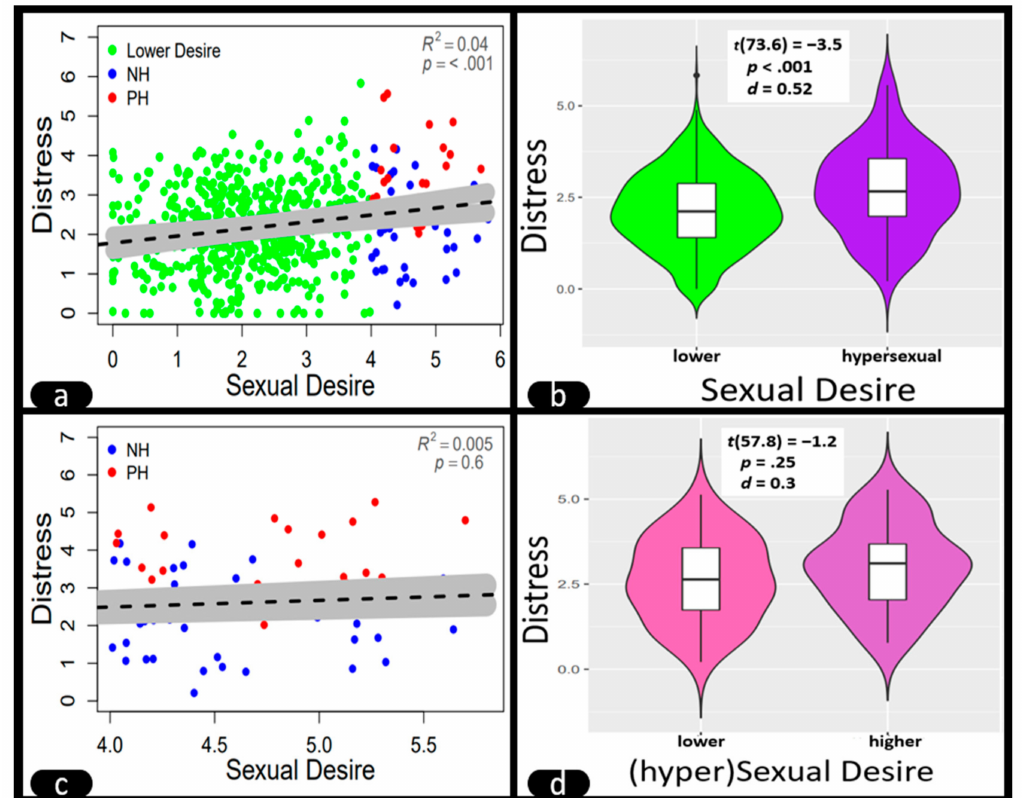
Figure 2. Comparing relevant subpopulations. ( a ) Scatterplot of sexual desire and distress in a general population sample. Part of this sample can be considered as PH (=red) or NH (=blue). Sexual desire is positively associated with distress. ( b ) Violin and boxplot comparing lower sexual desire and the hypersexual desire subsamples on levels of distress. The hypersexual sample (PH and NH) experiences significantly more distress than those with lower sexual desire levels. ( c ) Scatterplot of sexual desire and distress in the hypersexual subsample. Half of this sample can be considered as PH and the other half as NH. Sexual desire is not significantly associated with distress. ( d ) Violin and boxplot comparing lower (hyper)sexual desire and higher (hyper)sexual desire samples in the overall hypersexual sample. There is no difference in distress levels between both